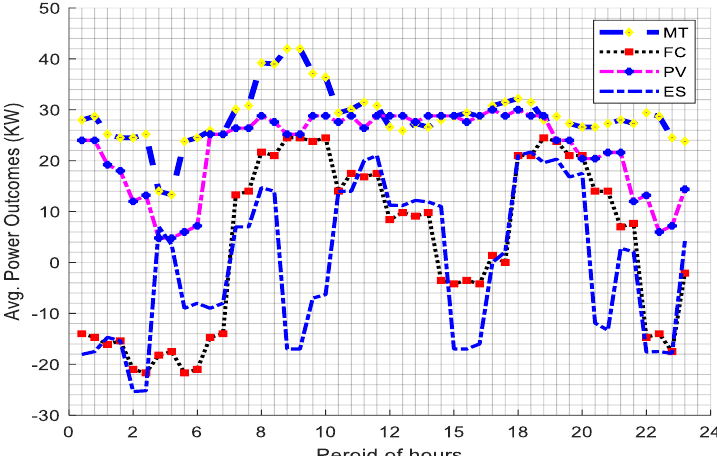
Figure 14. The production graphs of off-grid microgrid subsystem power supplies in daily cycle load.